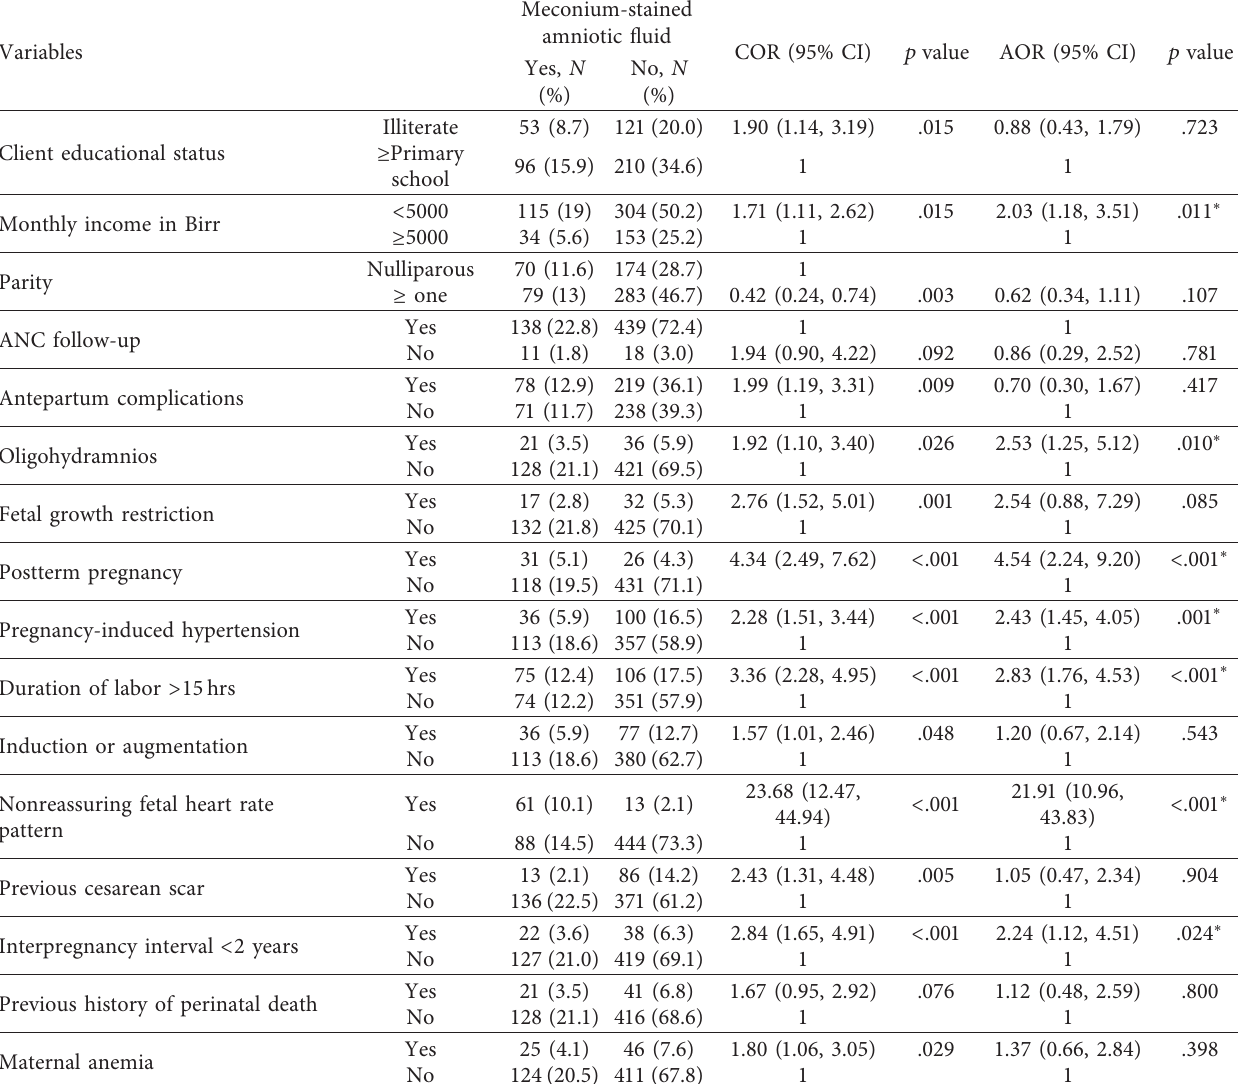
Table 4: Maternal factors associated with meconium-stained amniotic fluid, bivariate and multivariable logistic regression analysis, Felege Hiwot Referral Hospital, Ethiopia,